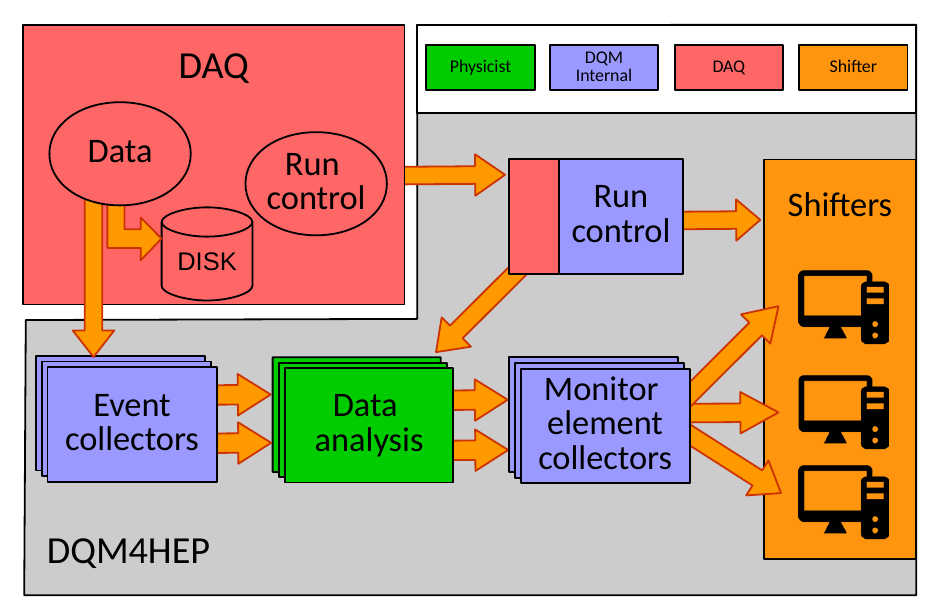
Figure 2. Online architecture of the DQM4hep framework. Data flow is indicated by the arrows. Physicists only have to dedicate time on the data analyses. The top left corner corresponds to the DAQ system and is not part of the framework, it is displayed here to show the link between the two